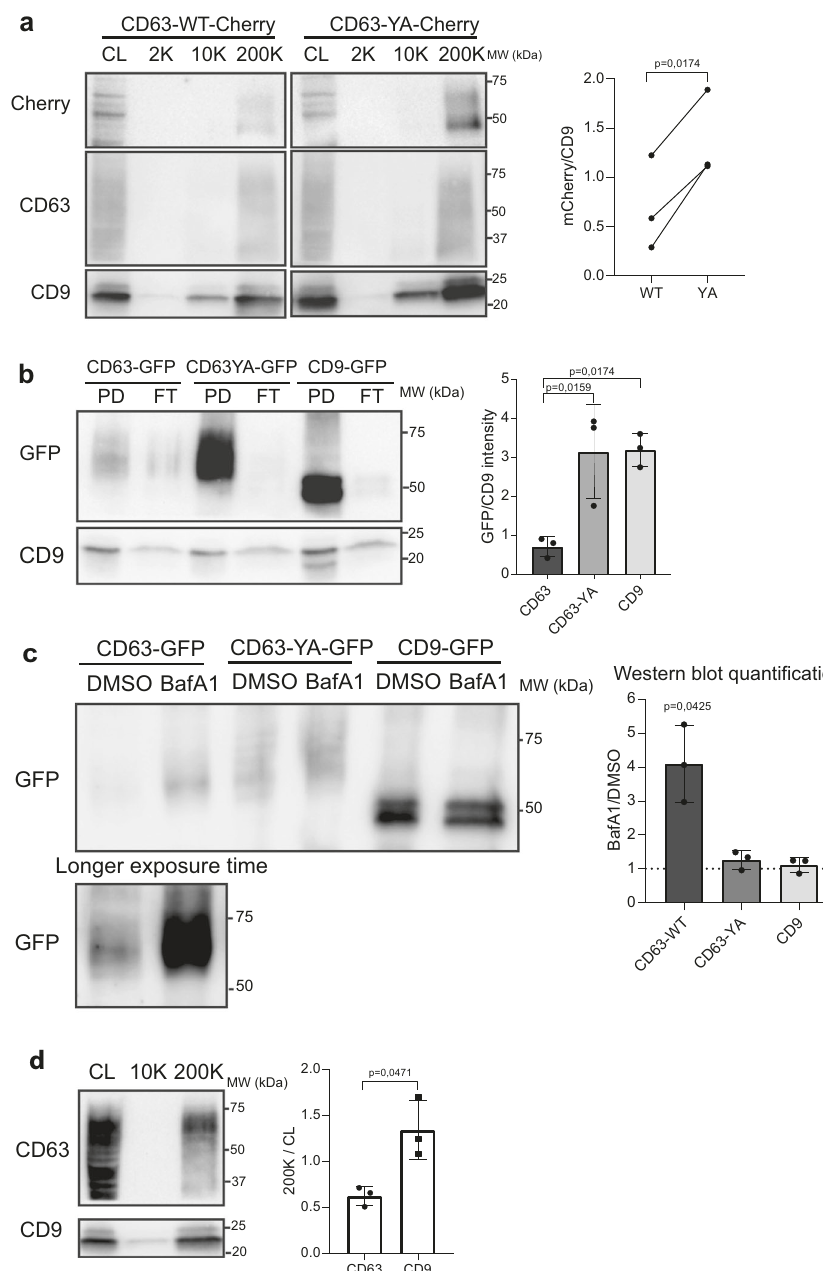
Fig. 5 CD63-WT is less ef fi ciently released in EVs than CD9 and CD63-YA. a Western blot of the cell lysate (CL) and of the different EV pellets obtained by differential ultracentrifugation of CCM from HeLa cells transfected with the RUSH plasmids CD63-WT-eGFP or CD63-YA-mCherry (24 h release with biotin). EVs from 20 × 10 6 cells and CL from 0.2 × 10 6 cells were loaded. The intensity of the band corresponding to the mCherry fusion proteins was quanti fi ed and normalized by the intensity of the CD9 band in 3 independent experiments, the mean ± SD is represented. Two-tailed paired t test. b Representative Western blot of the pull-down (PD) and fl ow-through (FT) of the immunoprecipitation of EVs from HeLa cells transfected with the RUSH plasmids CD63-WT-eGFP , CD63-YA-eGFP , or CD9-eGFP , recovered 24 h after biotin addition. 60 × 10 8 total particles quanti fi ed by NTA were used for each IP. Percent of GFP + cells quanti fi ed by fl ow cytometry were similar in the three conditions (Supplementary Fig. 5a). The GFP bands intensity in the PD normalized to endogenous CD9 in the corresponding PD are represented as mean ± SD for 3 independent experiments. Ordinary one-way ANOVA, Tukey ’ s multiple comparisons test. c Representative Western blot of EVs (200 K pellets) from HeLa cells transfected with the CD63-WT , CD63-YA , or CD9- eGFP RUSH plasmids treated with DMSO of BafA1 100 nM during 16 h. The same number of EVs between the DMSO and the BafA1 conditions were loaded on the gel (around 100 × 10 8 particles). The fold change between DMSO and BafA1 treatment for each construct is represented as mean ± SD for 3 independent experiments. Two-tailed one sample t test to compare each condition with a theoretical mean of 1. d Proportion of cellular endogenous CD9 and CD63 released in EVs, as semi-quanti fi ed on Western blots. The signal for CD9 and CD63 in 200 K pellets released by 20 × 10 6 HeLa cells was divided by the signal for the same molecule in the total lysate of 0.2 × 10 6 cells, run on the same blot. 1 representative Western blot and quanti fi cation (mean ± SD) of 3 independent experiments. Two-tailed paired t